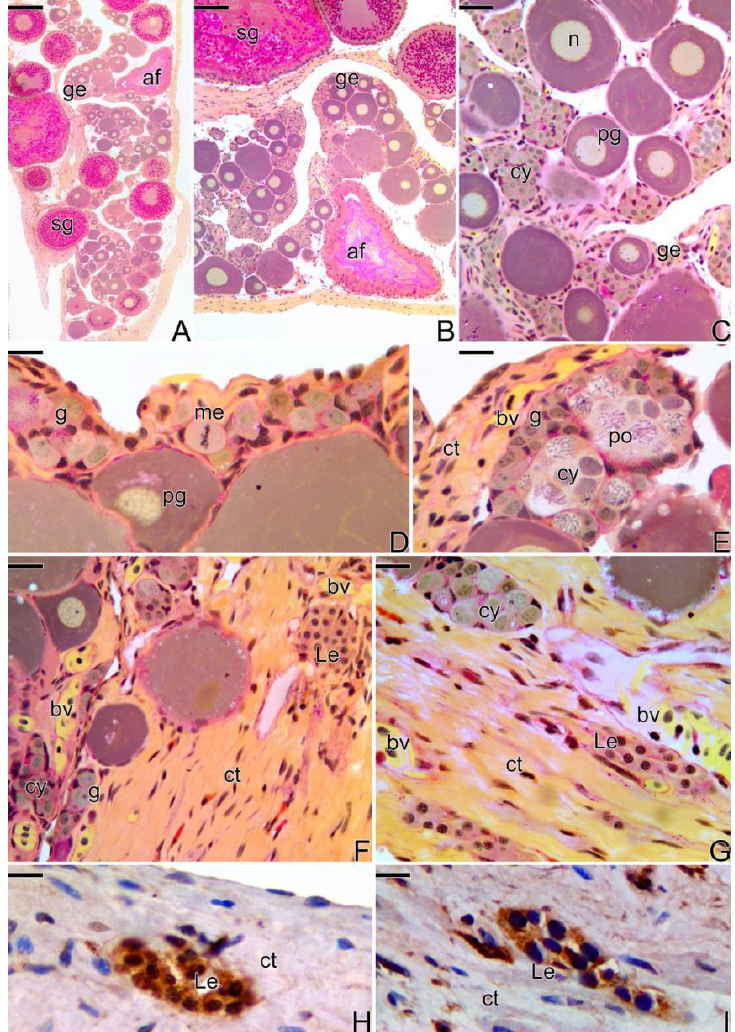
Figure 3. Histological sections of ovary at the beginning of gonadal transition of S. marmoratus . Note the presence of atretic follicles ( A , B ), a greater number of germline cysts, along the epithelium ( C – E ), increased blood vessels and connective tissue in the interstitial compartment, and the presence of Leydig cells, close to the blood vessels ( F – H ) Immunohistochemistry for detection of PCNA. The labeled cells that show positive response to PCNA ( H ) are Leydig cells. ( I ) Immunohistochemistry for detection of 3β-HSD enzyme, indicating that it is a steroidogenic cell. Germinal epithelium (ge), secondary growth oocyte (sg), atretic follicle (af), germline cyst (cy), nucleus (n), primary growth oocyte (pg), metaphase (me), gonia (g), connective tissue (ct), pachytene oocyte (po), blood vessel (bv), Leydig cell (Le). Staining: MY ( A – G ). Counterstaining: Harrys Hematoxylin ( H,I ). Bar: 200µm ( A ), 100µm ( B ), 20µm ( C , F ), 10µm ( D – I ). Throughout the process of folliculogenesis and entrance of the oocyte into primary growth, the prophase oocytes, as well as the primary growth oocytes (Figure 3A–F), remain involved by somatic cells, as well as the pre-follicle and follicle cells, respectively, which synthesize a basement